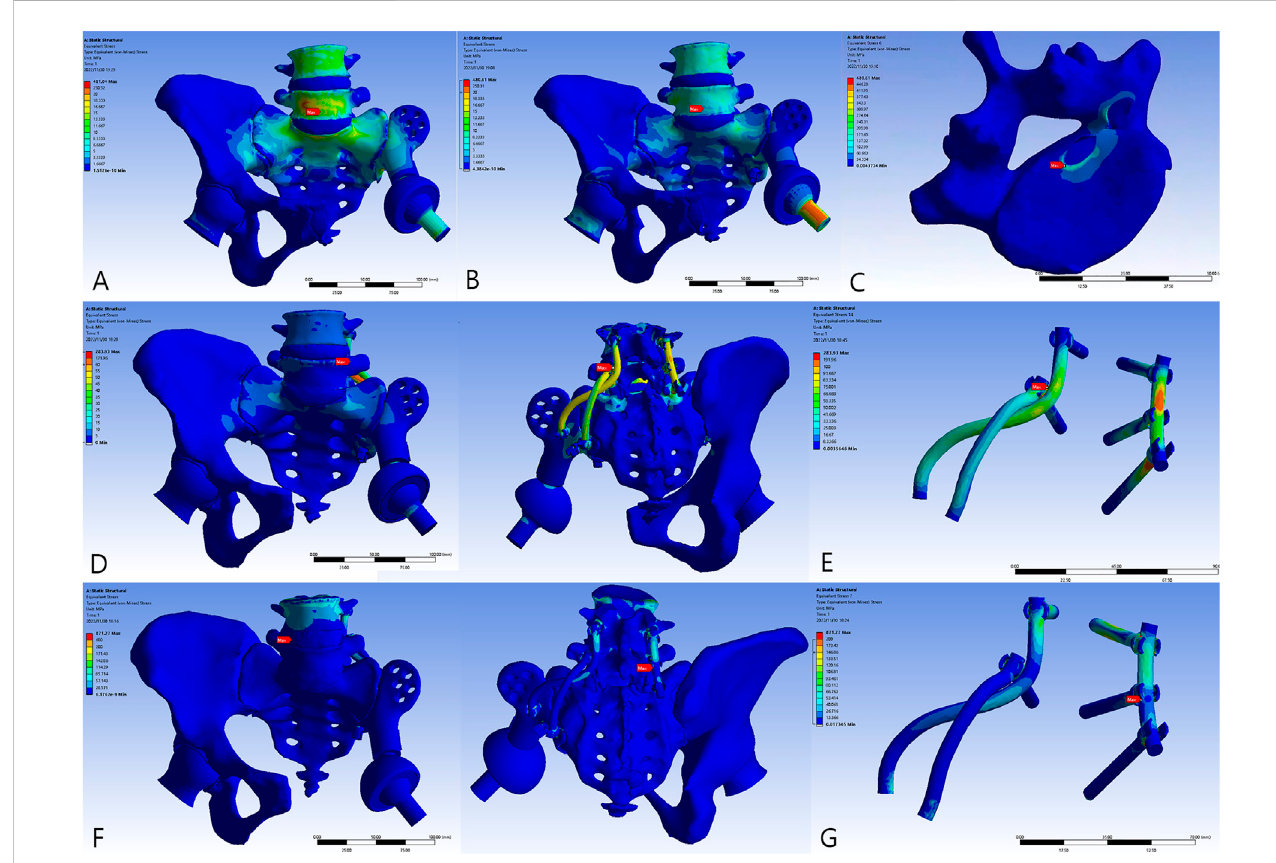
FIGURE 4 ThevonMisesforceofthemodels. (A) Model1_B. (B) Model2_B. (C) ThepeakforceofModel2_B. (D) Model3_B. (E) ThepeakforceofModel3_Batthe locking site of the pedicle screw and the rod. (F) Model 3_E. (G) The peak force of Model 3_E at the pedicle screw – rod system of the healthy side.